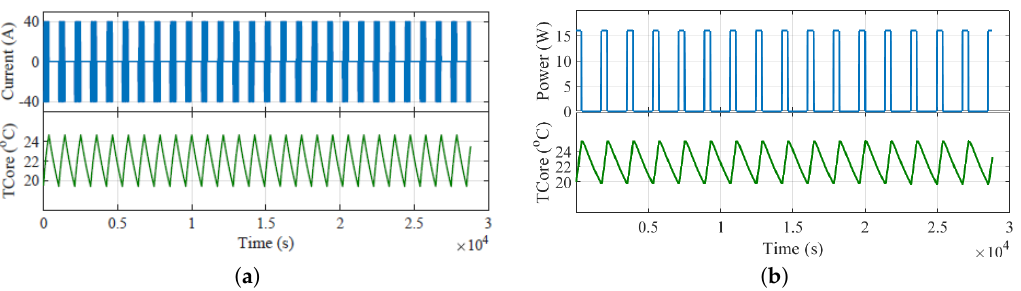
Figure 8. Simulation results for 10 ◦ C ambient temperature with ( a ) the APC method; ( b ) the HP. Current (blue) and battery cell’s core temperature (green) maintained between 20 ◦ C and 25 ◦ C.